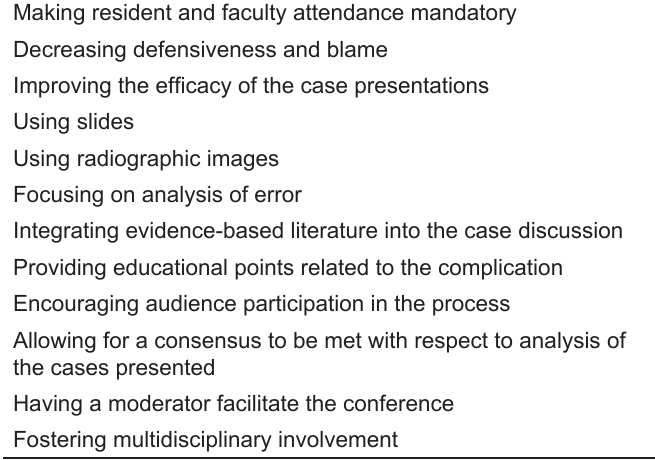
Adapted from Mitchell et al 2013.